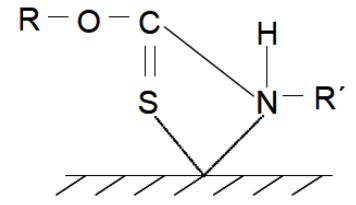
Figure 21. Schematic representation of the interaction of the thionocarbamate collector with copper atoms on the chalcopyrite surface.